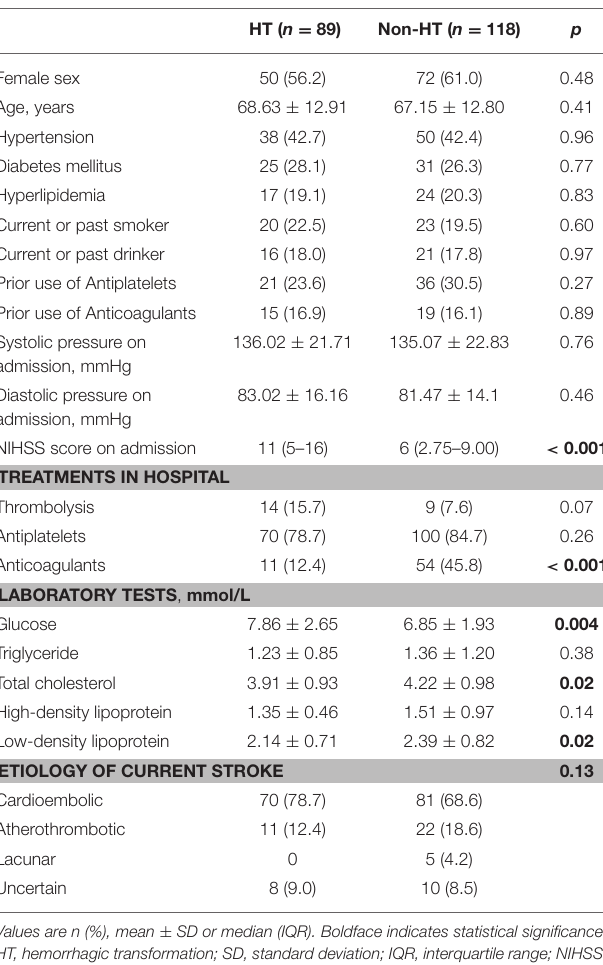
TABLE 1 | Differences in baseline characteristics between patients with or without HT.